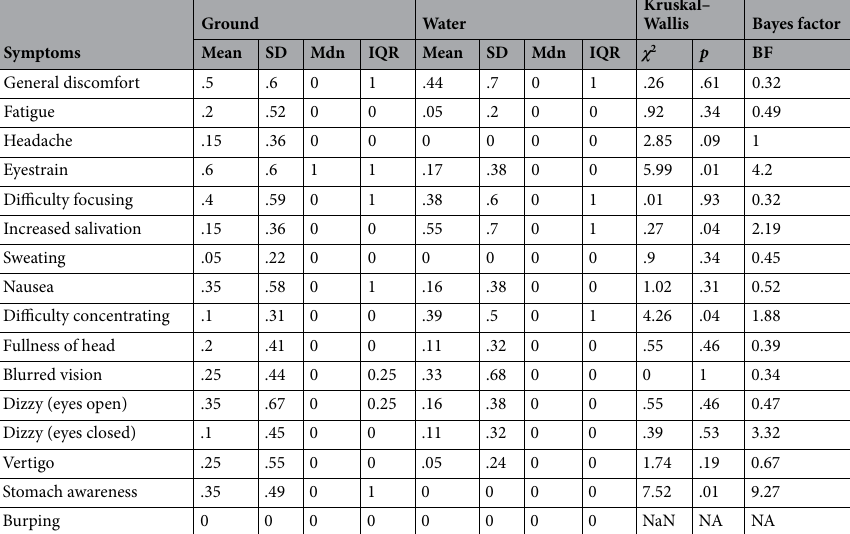
Table 1. Mean, standard deviation, median, interquartile range, Kruskal–Wallis’ χ 2 (1, n = 38) and p -value, and Bayes factors for the 16 SSQ items for each condition.